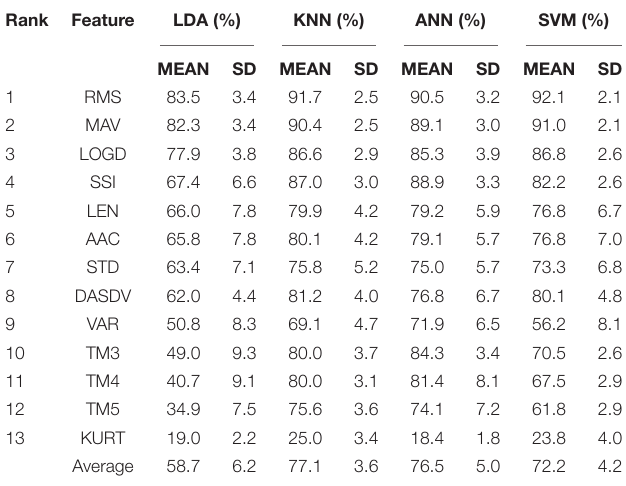
TABLE 1 | Average motion classification accuracy of the 13 time domain features (TDFs) across all the subjects and motion classes by using LDA, KNN, ANN, and SVM,